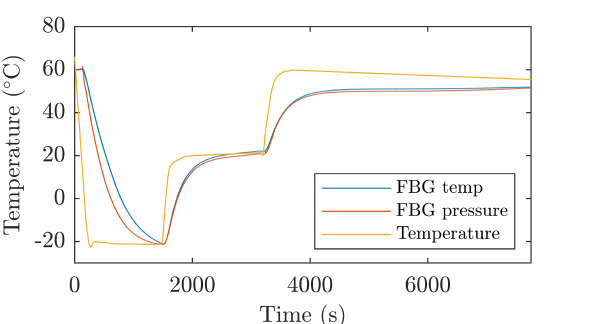
Figure 5. Temperature measurement using temperature FBG T and pressure FBG P Bragg grating in the temperature